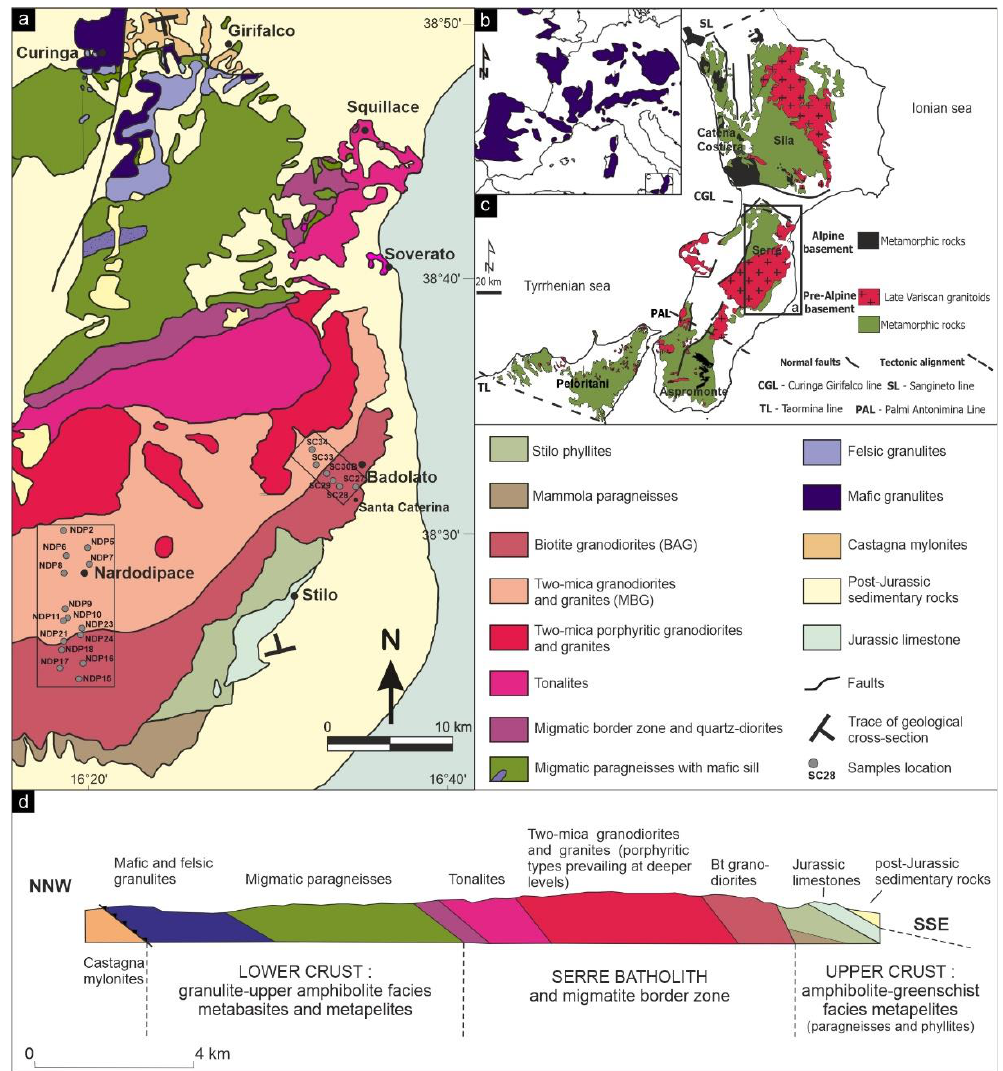
Figure 1. Geological sketch map of the Serre Massif (modified from [78] and references therein, adapted with permission from Elsevier) with black boxes indicating study areas: ( a ). Insets show; ( b ) distribution of pre-Alpine basement in western Europe [29,30,58], adapted with permission from Elsevier; the square indicates the Calabria–Peloritani Orogen; ( c ) distribution of Alpine and pre-Alpine (Variscan and/or pre-Variscan) basement rocks in the Calabria–Peloritani Orogen and main tectonic alignments; ( d ) simplified lithological cross-section of the Serre Massif, whose orientation is marked in ( a